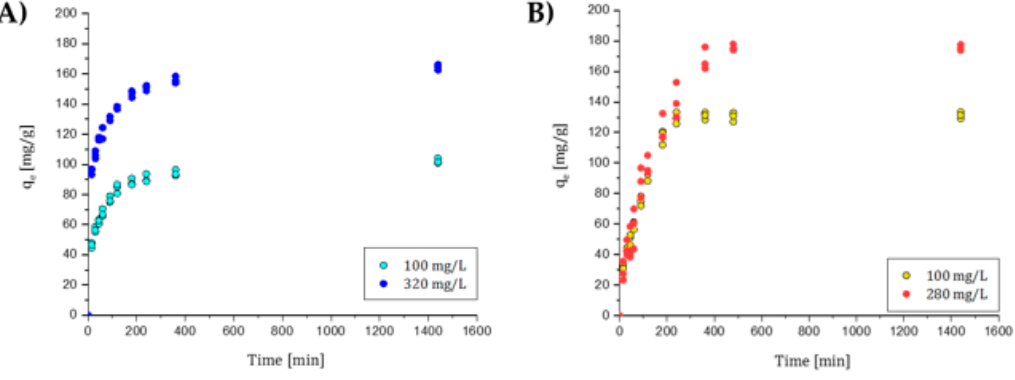
Figure 8. ( A ) BB kinetic behavior. Initial concentration of 100 and 320 mg/L. ( B ) CBY kinetic behavior. Initial concentration of 100 and 280 mg/L.